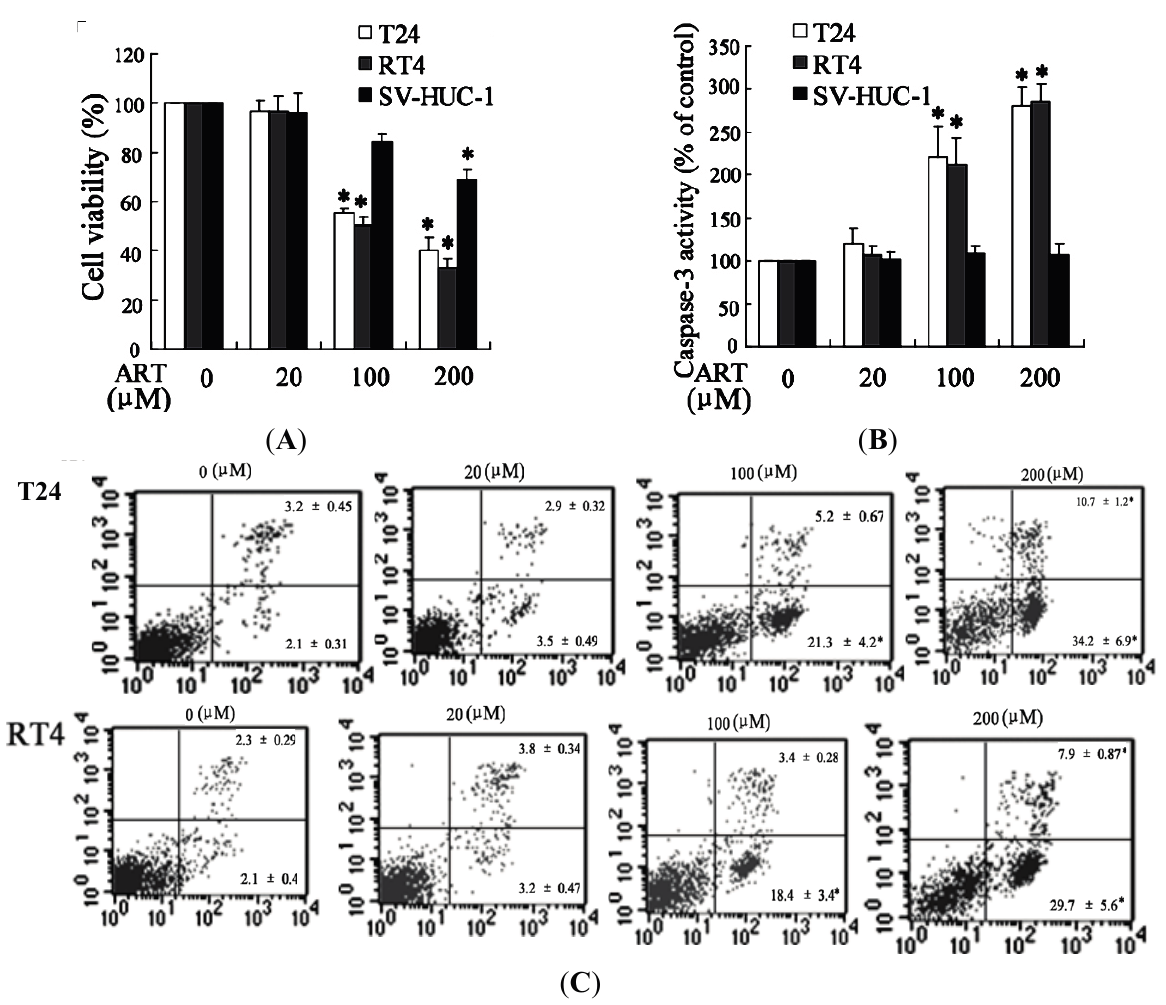
Figure 3. ART induced cytotoxicity and apoptosis in bladder cancer cells. The cell viability and caspase-3 activity were determined in T24, RT4 and SV-HUC-1 cells exposed to various concentrations of ART for 48 h ( A , B ); The apoptosis of T24 and RT4 cells were treated with different concentrations of ART for 48 h and then measured with